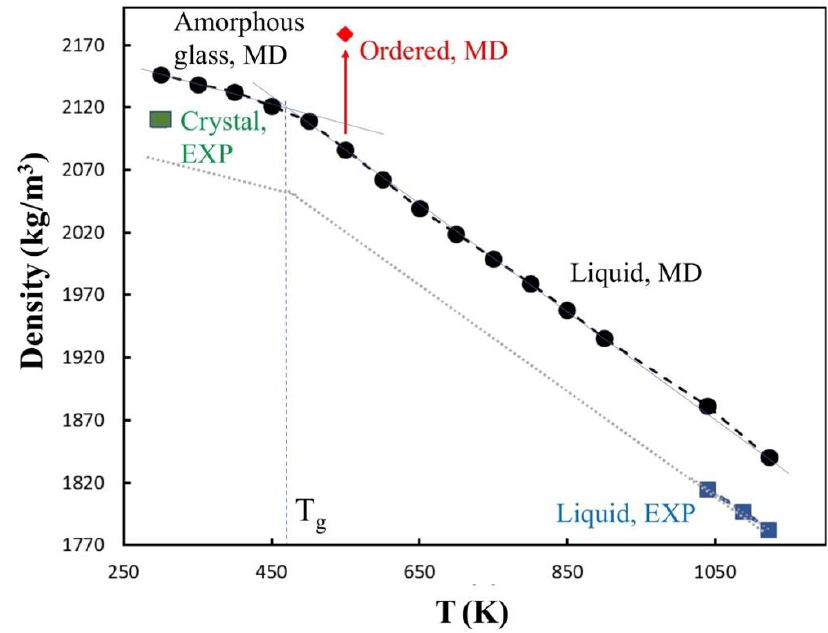
Figure 2. Temperature dependence of density obtained from molecular dynamics (MD) simulation of amorphous Li 2 CO 3 . Also shown are available experimental data for liquid and crystal phases, density of the ordered phase obtained in some systems from MD simulations at 550 K, and anticipated extrapolation of experimental density (thin dotted line) for amorphous phase assuming temperature dependence as in MD simulations. Error bars are smaller than the symbol